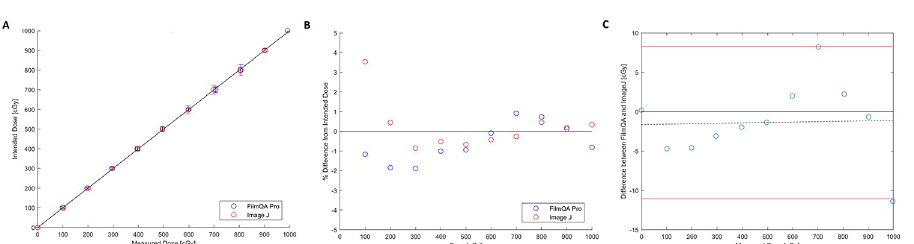
Fig 5. EBT3 for the 0–1000 cGy dose range. A) Measured vs. intended dose. The solid line has a slope of one and is meant to guide the eye, as points falling on it indicate perfect agreement. Error bars represent 3 standard deviations. B) Percent difference from intended dose. C) Bland-Altman